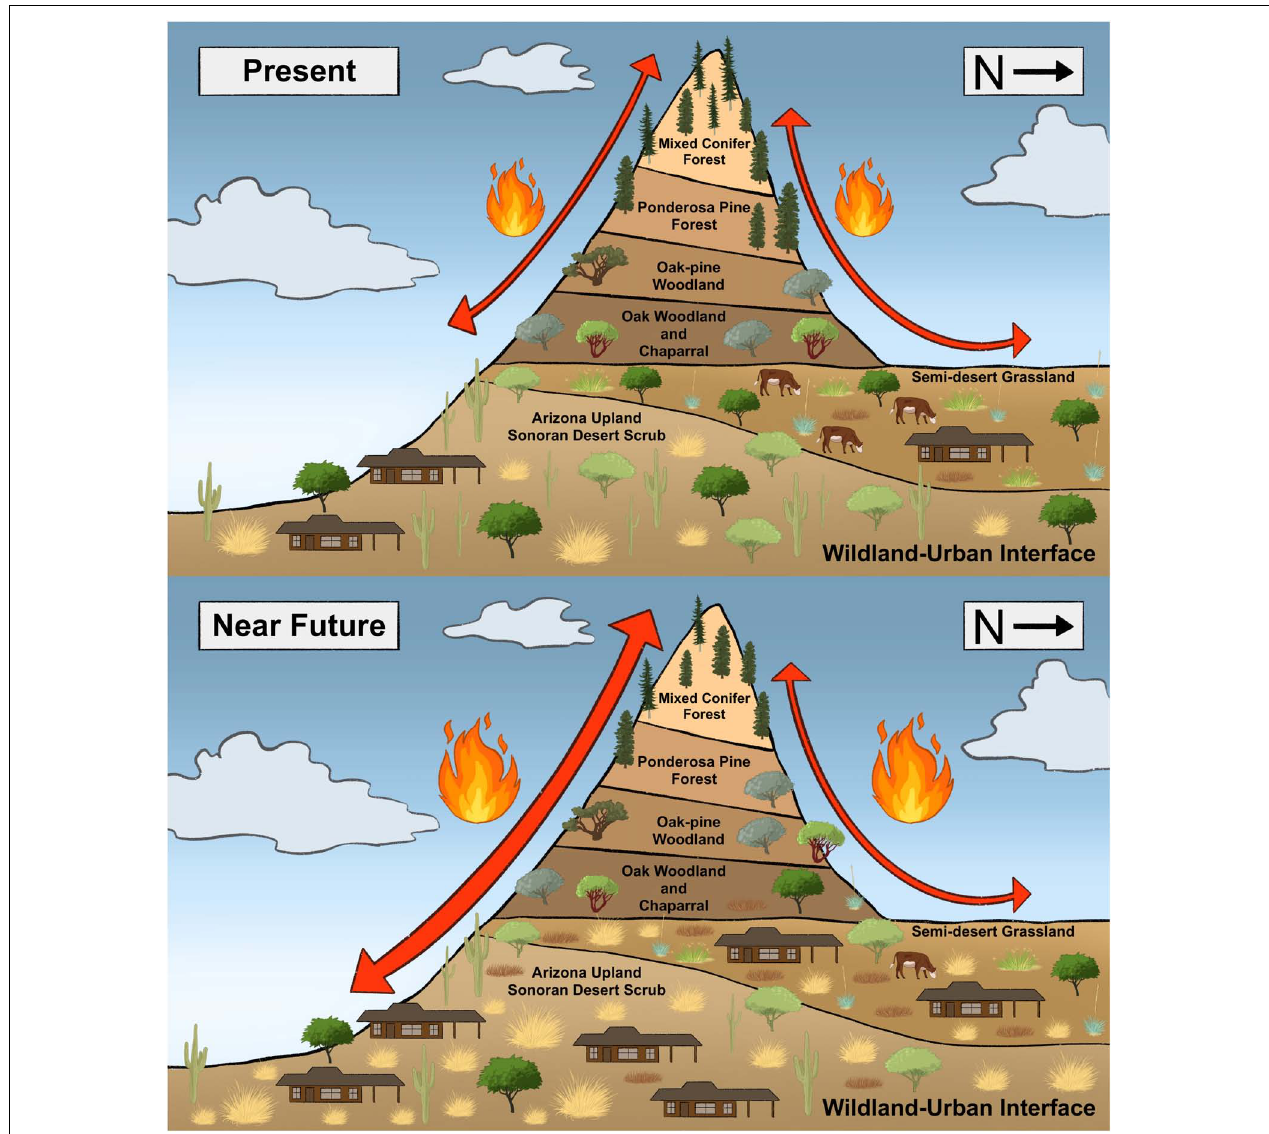
FIGURE 1 | Conceptual representation of grassification driven fire connectivity of the Sky Islands of arid North America. Present conditions have an expanding front of non-native grasses that will promote an increase of fuels and connectivity at the wildland-urban interface and the Desertscrub/Semi-desert Grassland ecotone in the coming years and couple decades (Figure by